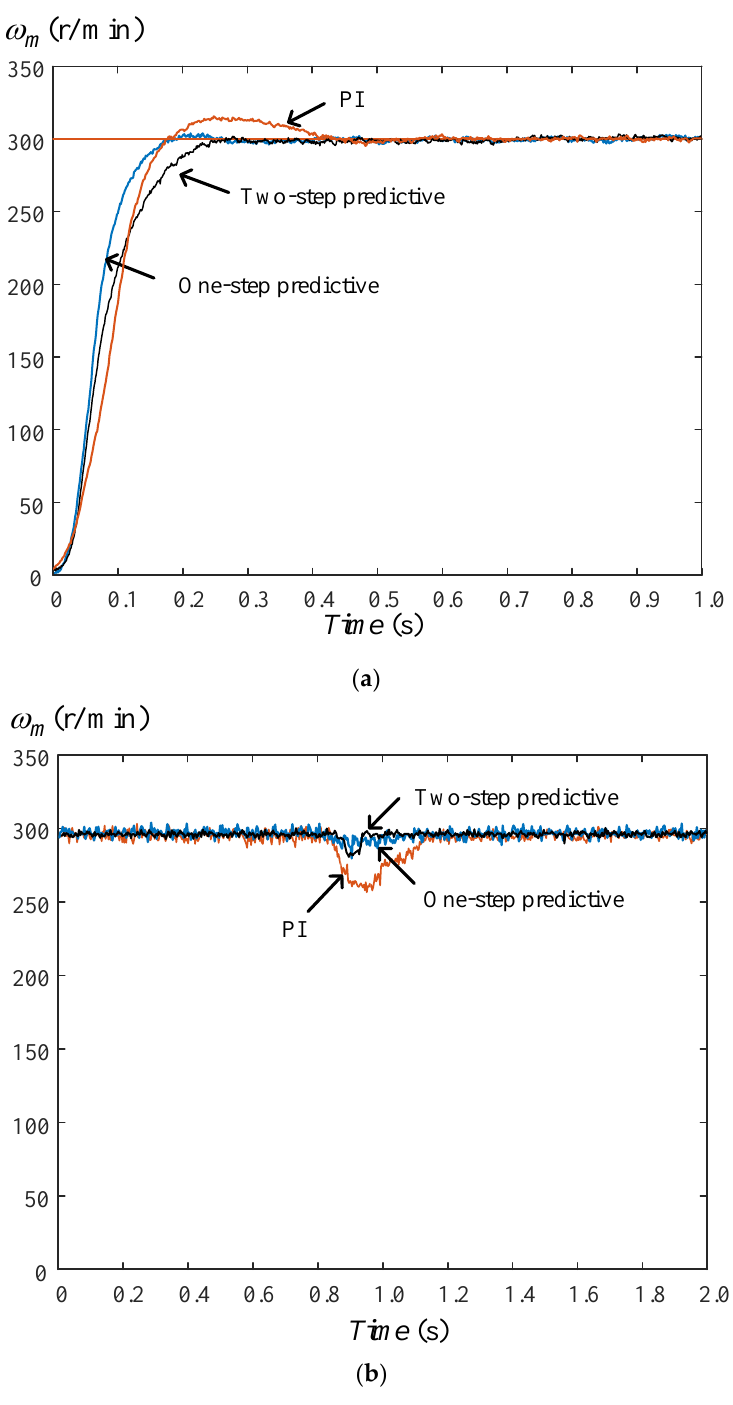
Figure 12. Measured speed responses. ( a ) Step-input responses, ( b ) load-disturbance responses.